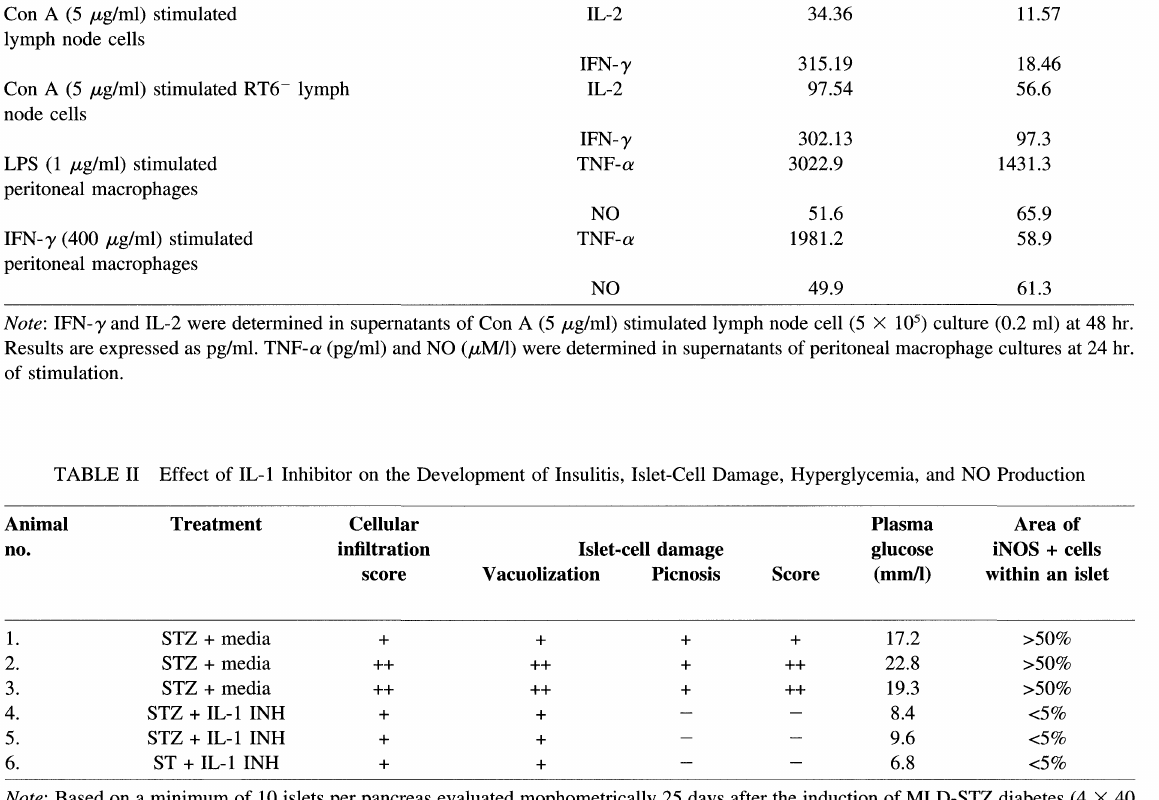
TABLE Interferon-y, Interleukin-2, Tumor Necrosis Factor-a and Nitric Oxide Production by Mononuclear Cells of MLD-STZ Diabetes-Susceptible (DA) and-Resistant (AO) Rats Producer cells Mediator AO Con A (5 /zg/ml) stimulated lymph node cells Con A (5/zg/ml) stimulated RT6- lymph